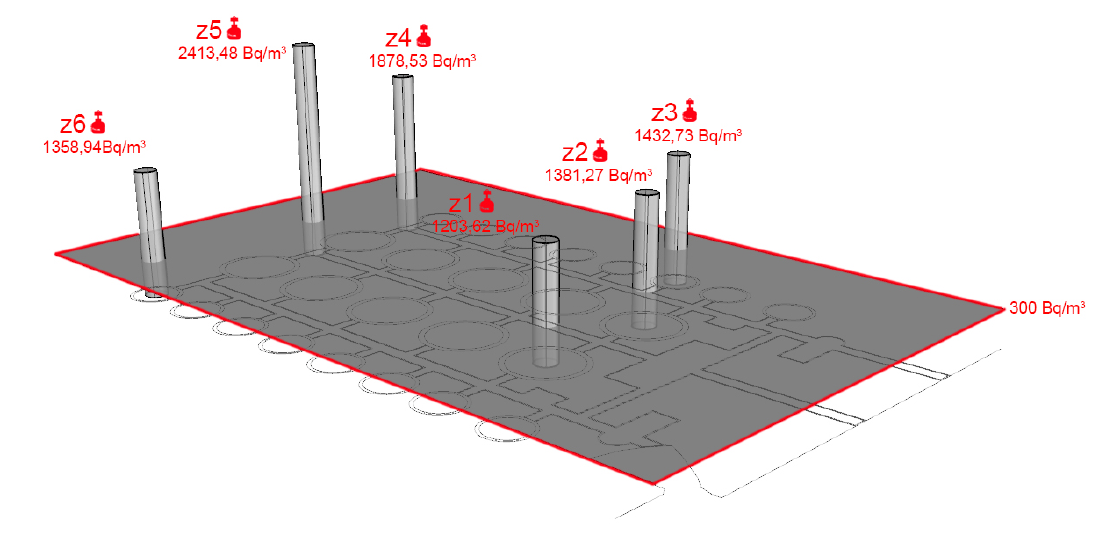
Figure 18. 3D graph of the results obtained, measured in Bq/m 3 . This graphic representation shows the complete plan of the building and the values obtained in each of the locations. In the plan, the parts marked in red show a value of 300 Bq/m 3 or above, and at these locations, measures must be taken to reduce the radon